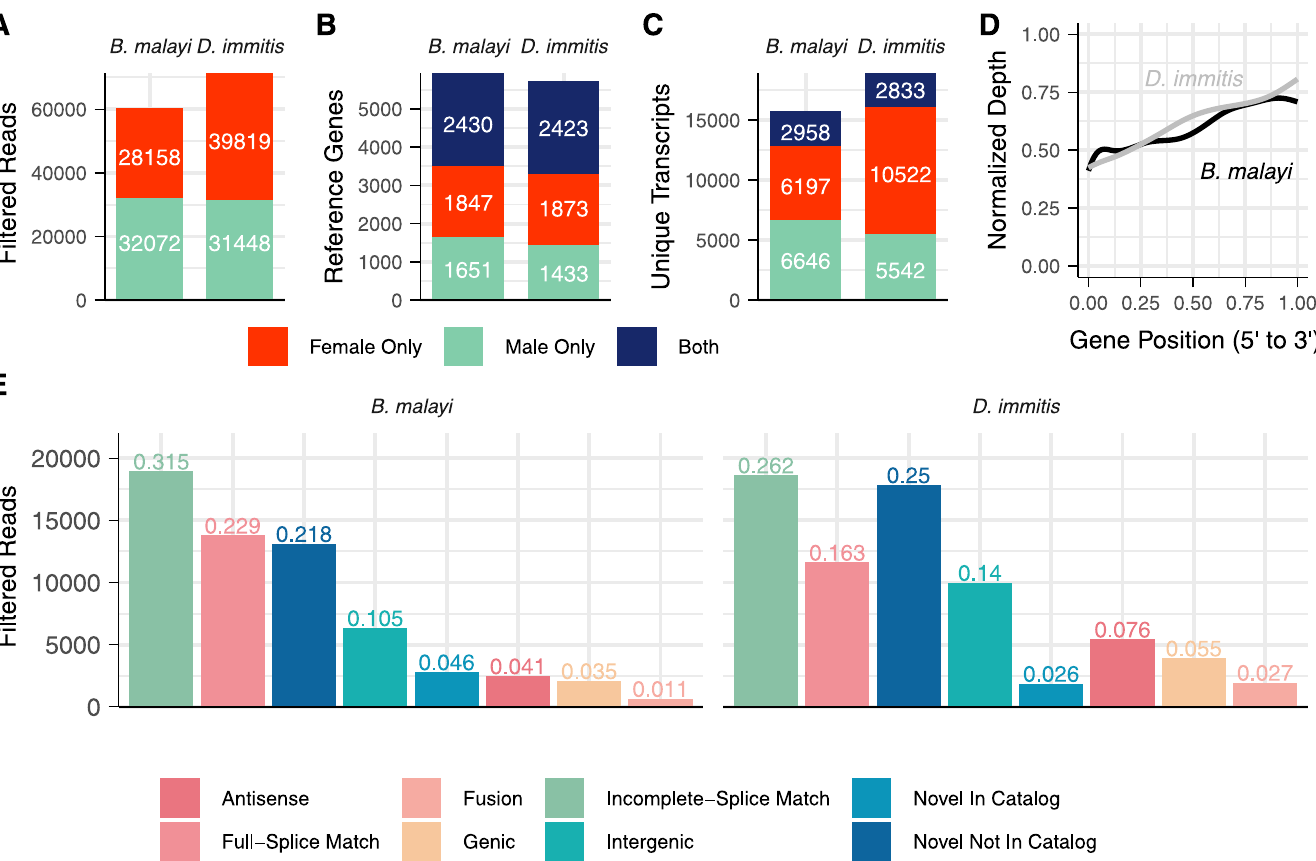
Fig 2. Summary of Iso-Seq data from adult male and female B . malayi and D . immitis . (A) The number of filtered reads generated from each sex and species. (B) The number of reference genes with at least one mapped read from only females, only males, or both sexes. (C) The number of unique transcripts captured from only females, only males, or both sexes. (D) Libraries arising from both species had a strong 3’ bias due to poly(A) selection and mRNA degradation. Depth was normalized to the maximum and minimum read depth for each species. (E) Distribution of SQANTI structural category assignments. Numbers above bars indicate the percentage of reads in each respective category. Antisense: maps to the opposite strand of a predicted gene. Full-splice match: confirms the annotated gene model. Fusion: maps to two consecutive genes. Genic: maps to a single exon within a predicted gene. Incomplete-splice match: partially confirms the annotated gene model. Intergenic: maps to an intergenic region. Novel in catalog: utilizes known splice sites in novel combinations. Novel not in catalog: uses novel splice sites.